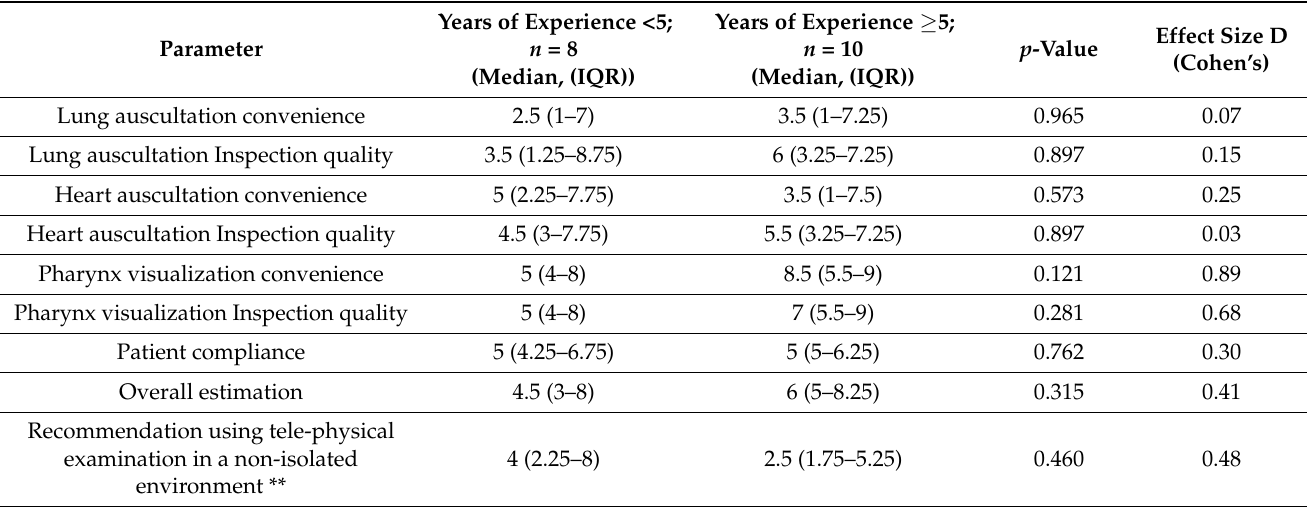
Table 3. Physicians’ differential preferences for examination modalities according to seniority: score of 5 marking indifference between modalities while 1 indicates a major preference in favor of the standard physical examination and 9 indicated a major preference in favor of the TytoCare ® system.